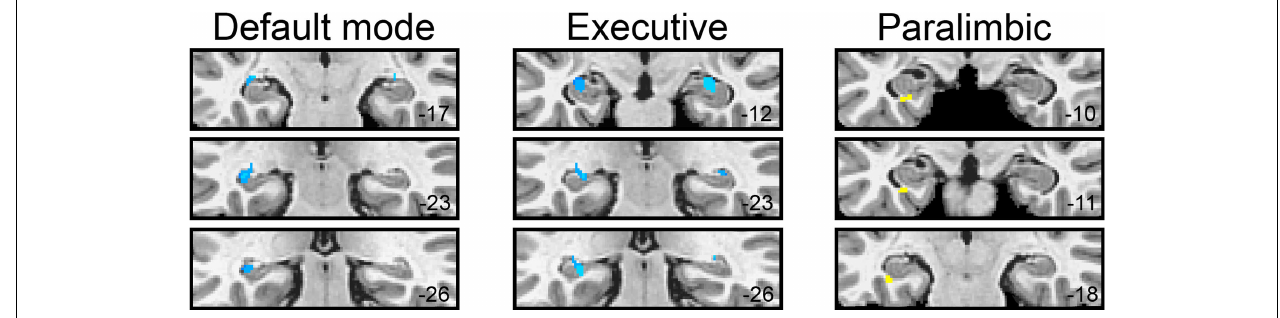
FIGURE 4 | BDNF gene group differences (val/val > val/met: blue; val/met > val/val: yellow) for each of the three resting networks within hippocampal